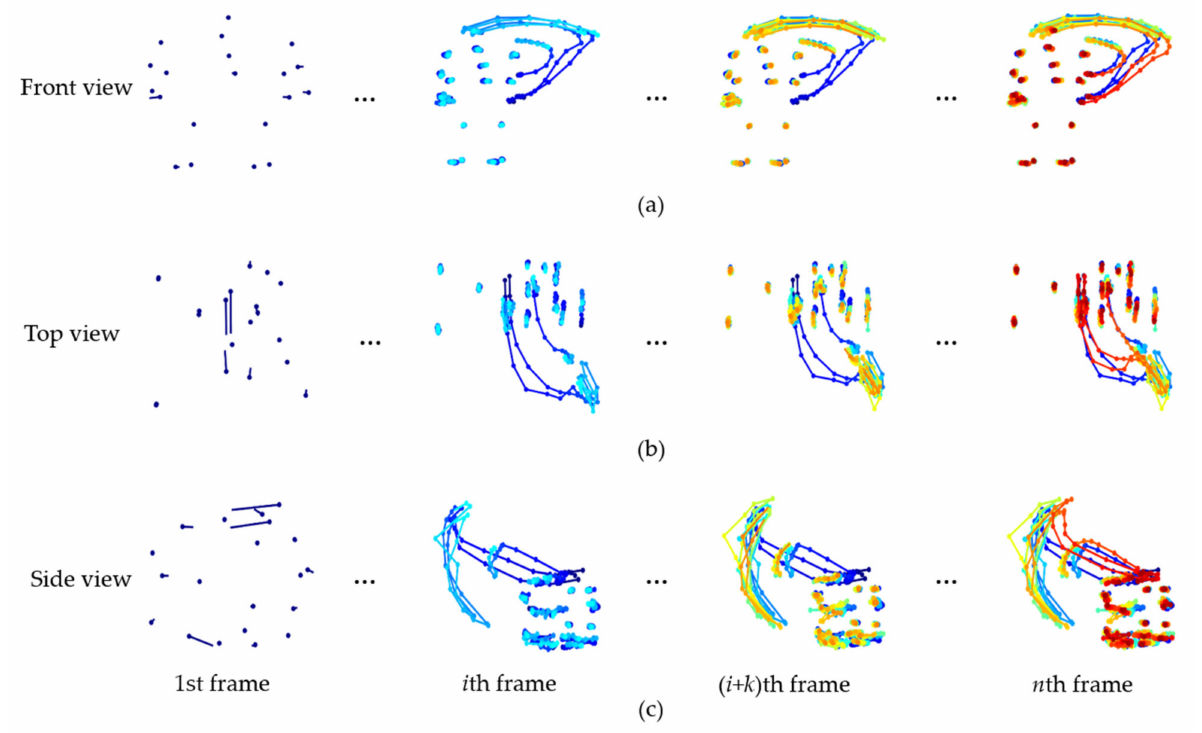
Figure 8. STIF representation of ‘HighArmWave’ action in MSR-Action3D dataset; ( a ) front view (along XY plane), ( b ) side view (along YZ plane), and ( c ) top view (along ZX plane).